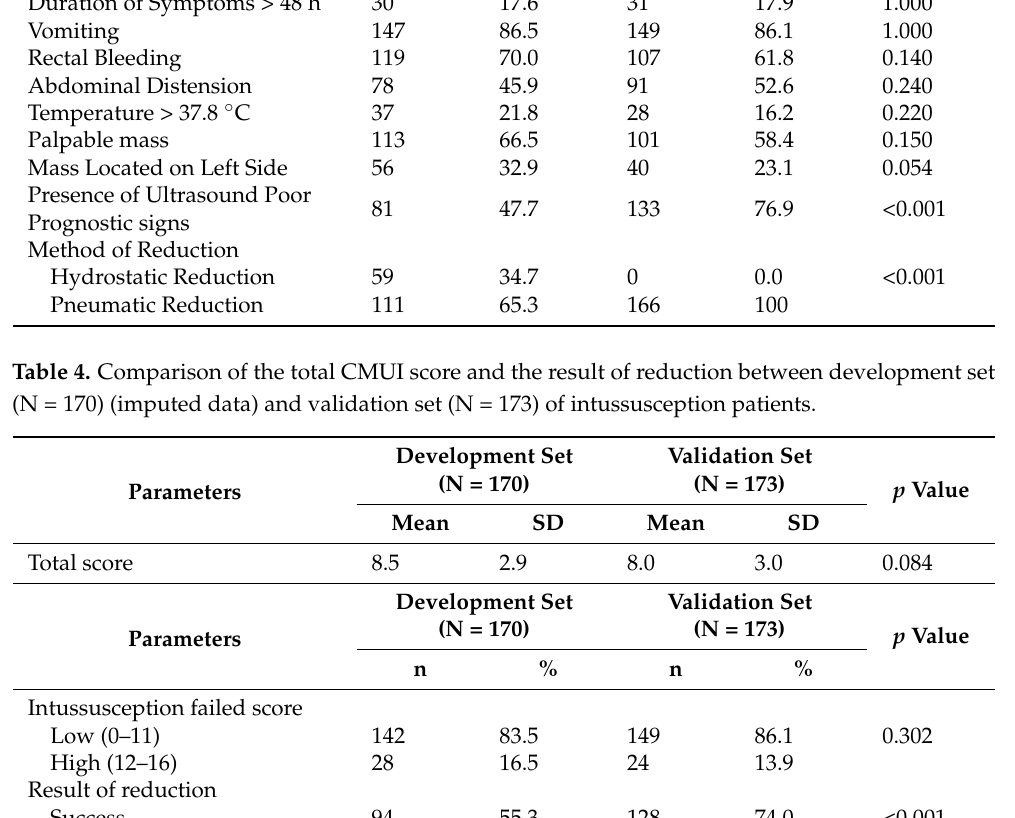
Table 3. Comparison of ten score variables between development set (N = 170) (imputed data) and validation set (N = 173) of intussusception patients. Development Set Variables